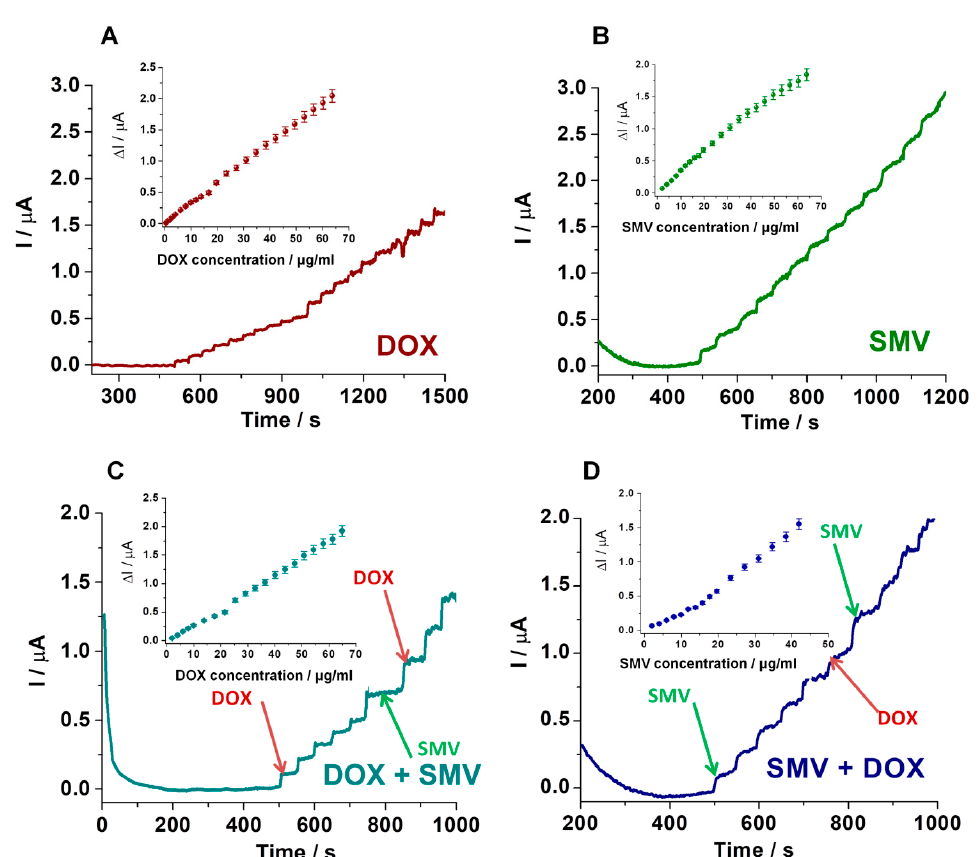
Figure 9. Chronoamperometry (CA) results obtained for successive additions of specific volumes of: 1 mg.mL DOX solution in 5 mL PB pH 5 + 25% EtOH at 0.5 V/Ag/AgCl ( A ); 1 mg.mL SMV solution in 5 mL PB pH 5 + 25% EtOH at 0.95 V/Ag/AgCl ( B ); Inset: calibrations curves of DOX and SMV alone using CA. Selectivity tests performed with amperometry for: addition of SMV between successive additions of DOX ( C ); addition of DOX between successive additions of SMV ( D ); Inset: calibrations curves of DOX in the presence of SMV and SMV in the presence of DOX, respectively (PB pH 5 + 25% EtOH, in CA at 0.95 V; under stirring conditions). Error bars were calculated based on the standard deviation obtained for 3 tests on 3 different electrodes.